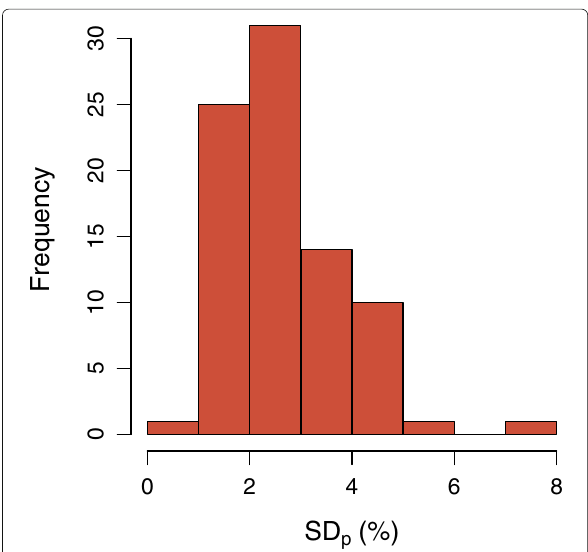
Fig. 4 Histogram of patient-specific interobserver variability, described by SD p (Eq. 3), the standard deviation of the distribution of fractional deviations (cid:2) BSUV dp (Eq. 1) from observer mean for the respective patient grouped by patient as illustrated in Fig.